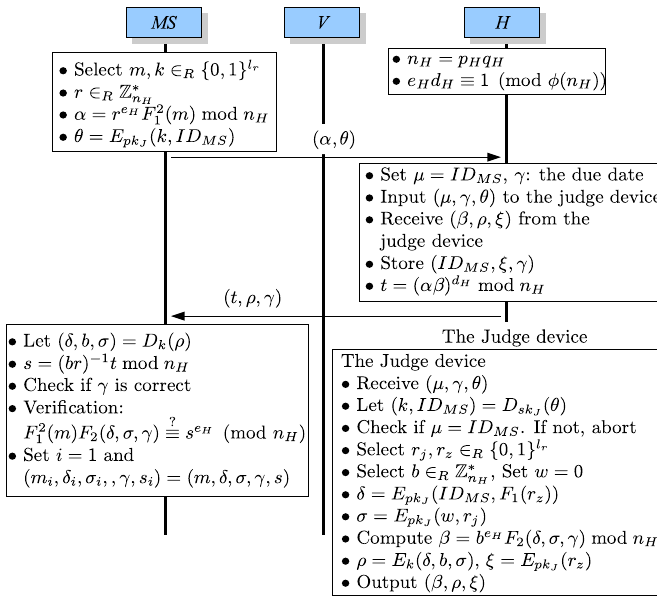
Figure 3. The protocol for requesting an initial anonymous